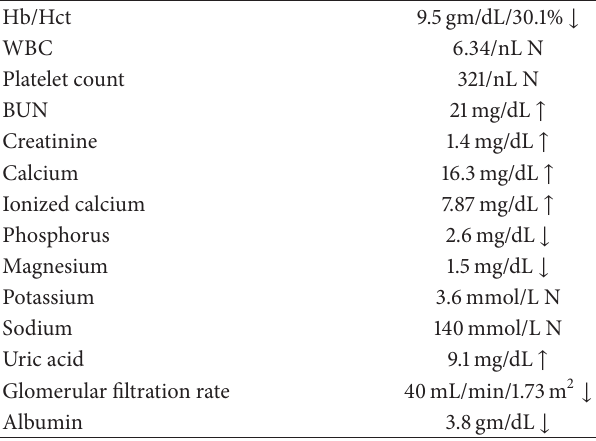
Table 1: Laboratory